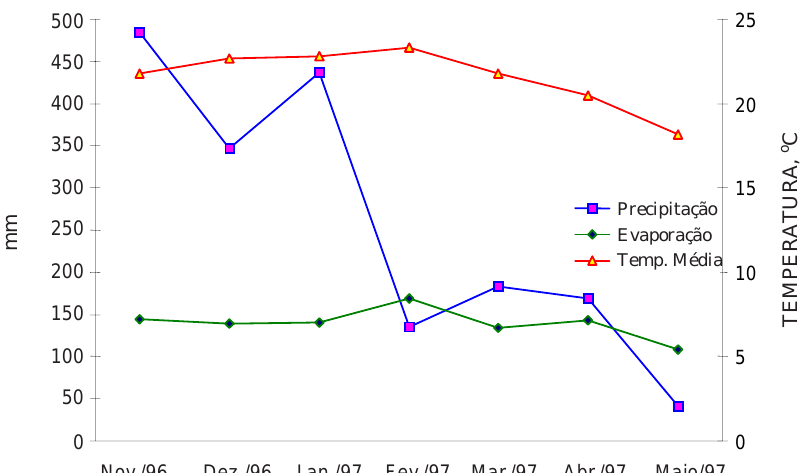
Figura 1. Médias mensais de precipitação, evaporação e temperatura média, observadas no período de novembro de 1996 a maio de 1997, em Sete Lagoas